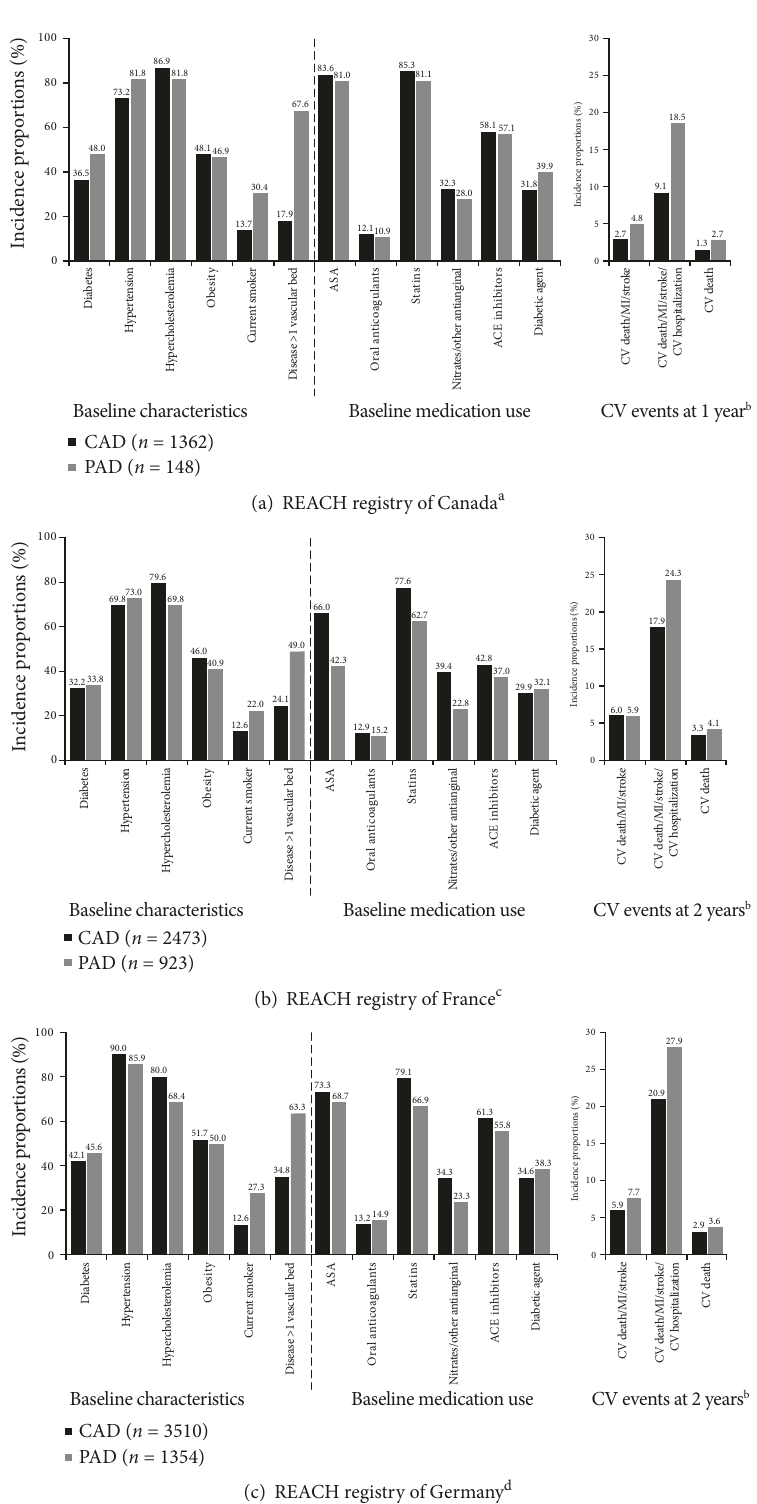
Figure 1: Baselinecharacteristicsand medication useand clinical outcomesin patients with CAD and PAD from the REACH Registries of (a) Canada, a (b) France, b and (c) Germany c [1, 2]. a Patients enrolled from January to October 2004; mean age 68.4 ± 9.9. b Percentage of patients experiencing at least one CV event (Figure (a): CAD n = 1356, PAD n = 146; Figure (b): CAD 𝑛 = 2397, PAD 𝑛 = 882; Figure (c): CAD 𝑛 = 3328, PAD 𝑛 = 1303). c Patients enrolled from December 2003 to June 2014; mean age 69.1–71.7 across risk groups. d Patients enrolled from December 2003 to June 2014; mean age 68.0–69.4 across risk groups. ACE, angiotensin-converting enzyme; ASA, acetylsalicylic acid; CAD, coronary artery disease; CV, cardiovascular; PAD, peripheral artery